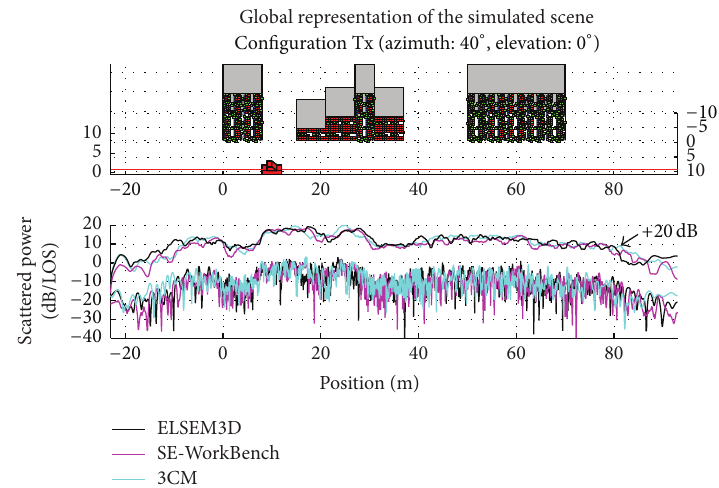
Figure 11: Total MP power scattered by a simple urban